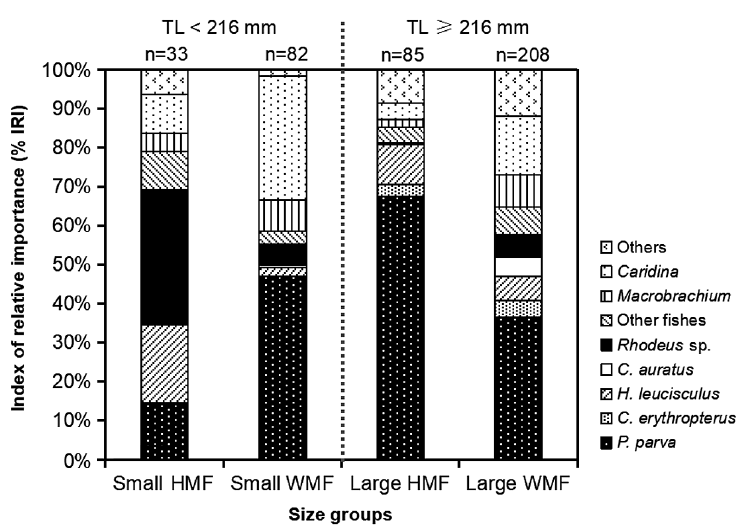
Fig. 4. Comparison of diet composition of hatchery-reared mandarin fish (HMF) and wild mandarin fish (WMF) size groups in Xiaosihai Lake, based on the index of relative importance (%IRI) of major prey groups from stomach content analysis. Sample sizes are above bars. TL: total